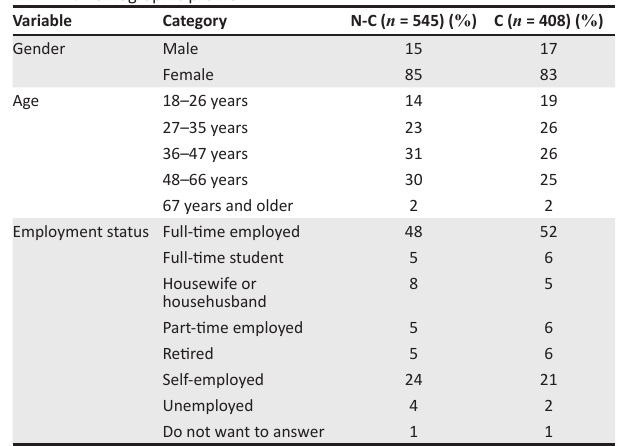
TABLE 1: Demographic profile.